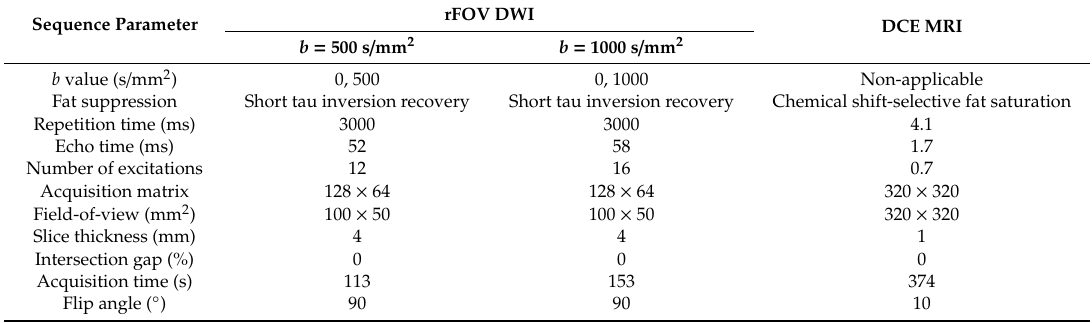
Table 1. Image acquisition parameters for reduced field-of-view (rFOV) di ff usion-weighted imaging (DWI) and dynamic contrast-enhanced magnetic resonance imaging (DCE